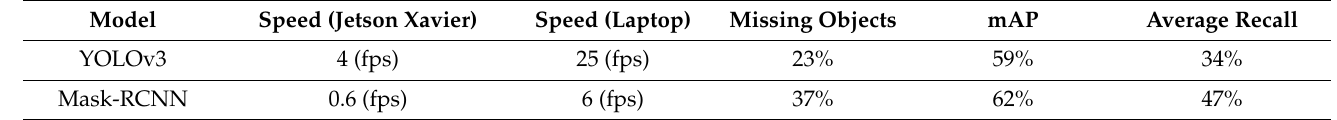
Table 2. YOLO and Mask-RCNN comparison results.